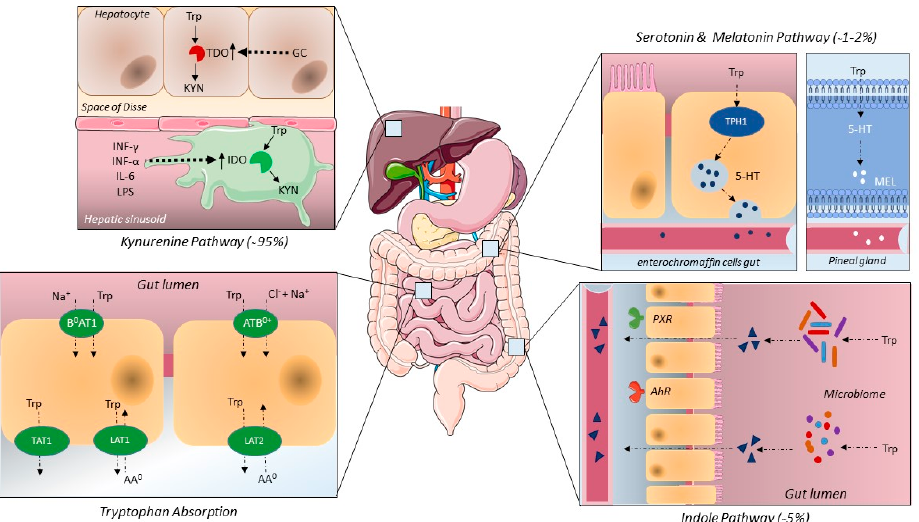
Figure 1. Tryptophan uptake and metabolism. Abbreviations: 5-HT; serotonin, AA 0 ; neutral amino acid, AhR; aryl hydrocarbon receptor, GC; glucocorticosteroids, IDO; idoleamine 2,3-dioxygenase, INF; interferon, IL; interleukin, KYN; kynurenine, LPS: Lipopolysaccharide, MEL; melatonin, PXR; Pregnane X receptor, TDO; tryptophan 2,3-dioxygenase, TPH1; tryptophan hydroxylase 1, Trp; tryptophan. Being a neutral amino acid, tryptophan is absorbed by ATB0+ (SLC6A14, a symporter using 2Na + /1Cl − ) and B0AT1 (SLC6A19, a symporter using 1Na + ) at the apical membrane of the small intestine and is excreted in to the portal circulation via the basolateral mem- brane by TAT1 (SLC16A10, a uniporter) or LAT1-4F2hc (SLC7A5-SLC3A2, an antiporter) and LAT2-4F2hc (SLC7A8-SLC3A2, an antiporter) [31,32]. These amino acid transporters are also referred to as system B+ (B0AT1/B0AT2), System B0+ (ATB0+), system L (LAT1- 4F2hc/LAT2-4F2hc) and system T (TAT1) [33]. These transporters often need to associate with other molecules such as angiotensin converting enzyme 2 (ACE2), CD98/CD147 [34] or aminopeptidase N [35]. Association with other proteins is thought to be necessary for transporter insertion in the cell membrane, to increase substrate supply or to modulate transporter activity [34]. Factors influencing the expression of these receptors and proteins are to date not completely elucidated. Once absorbed into the circulation, tryptophan is the only amino acid to bind to albumin (75–90%) [27,36]. Factors that negatively influence the amount of tryptophan bound to albumin are low albumin concentrations, certain drugs and non-esterified fatty acids